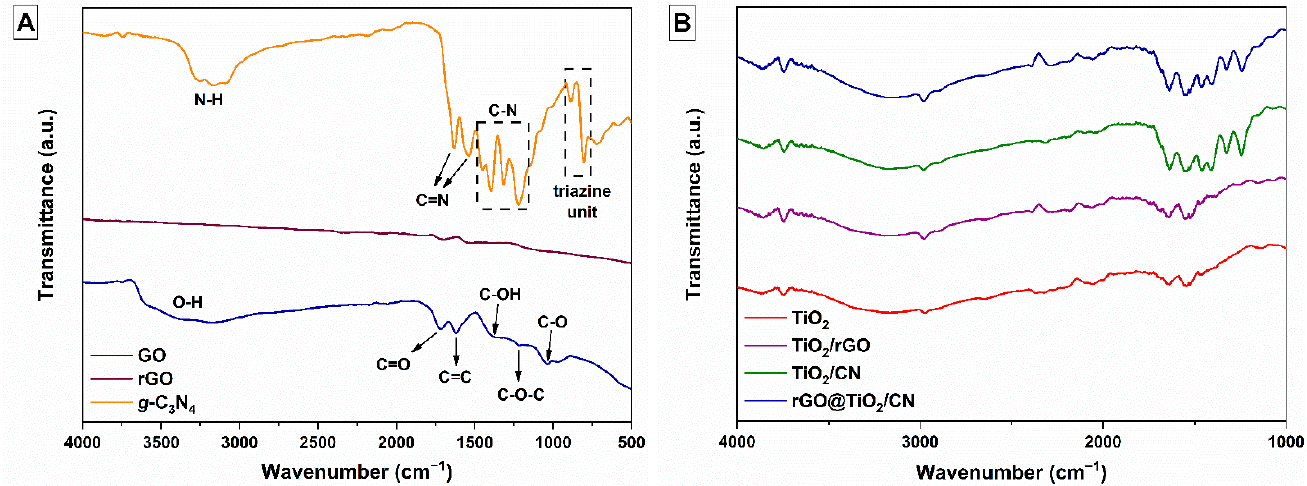
Figure 1. ( A ) FTIR spectra of as-prepared GO, rGO, and g -C 3 N 4 materials and ( B ) pure TiO 2 nanoparticles, TiO 2 /rGO, TiO 2 /CN nanocomposites, and rGO@TiO 2 /CN hybrid photocatalyst.